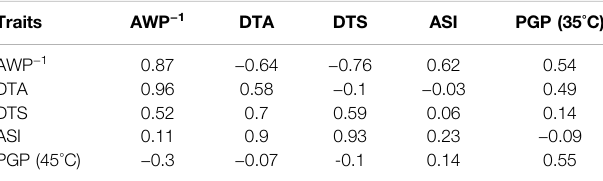
TABLE 2 | Correlation of traits under normal (above diagonal) and heat stress (below diagonal) conditions; diagonal shows the correlation between normal and heat stressed conditions for each trait.